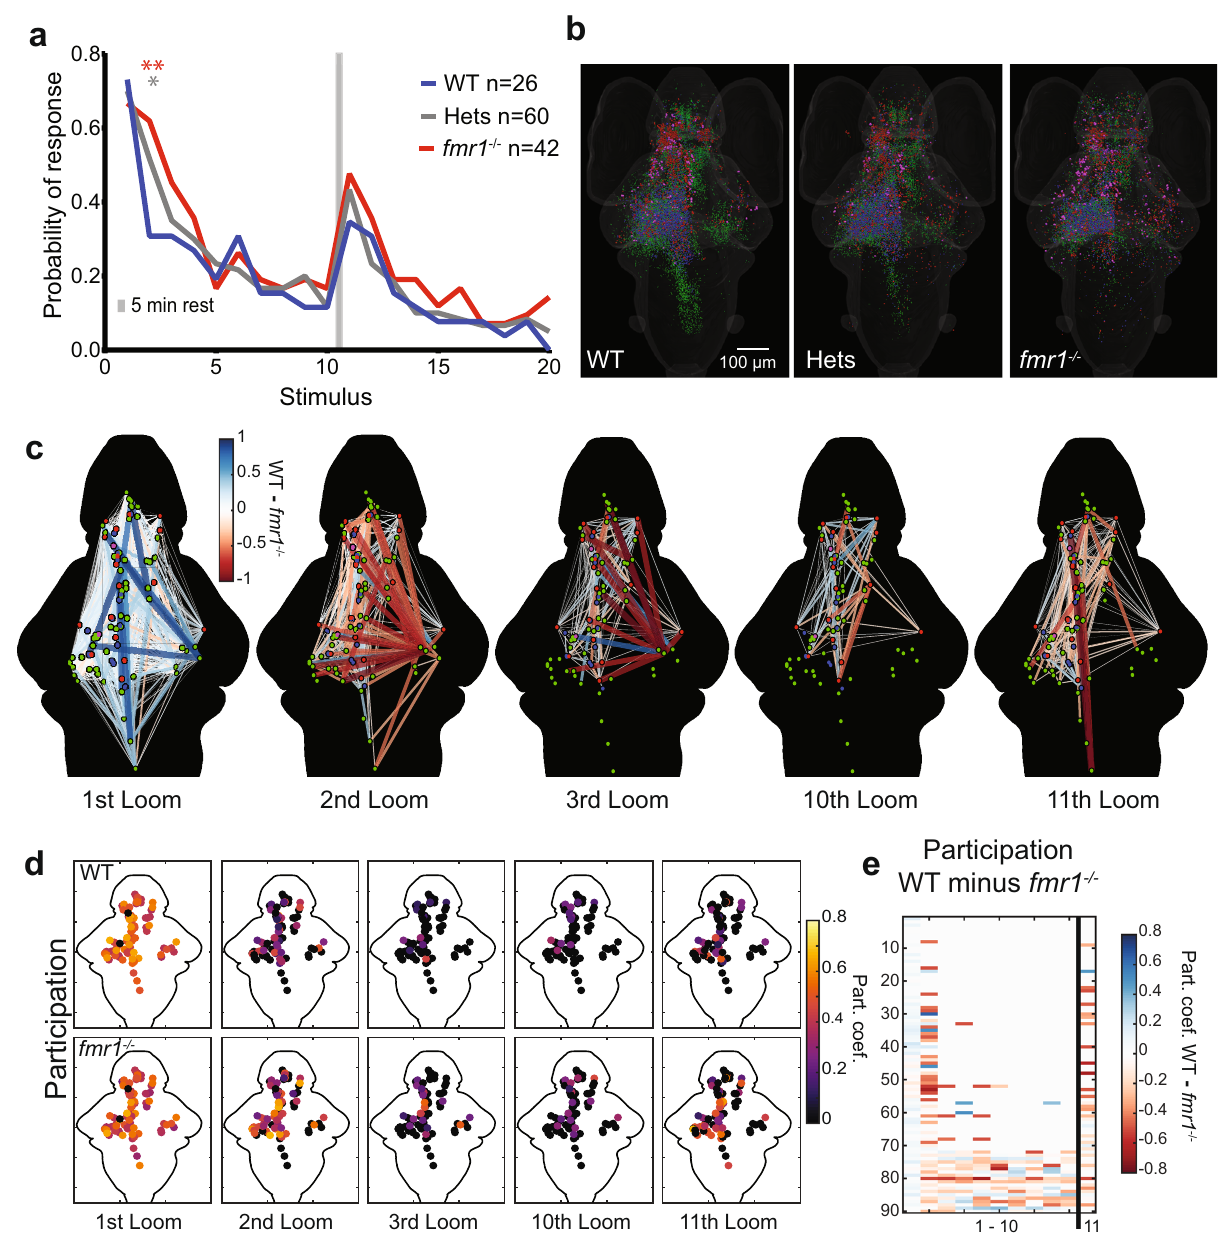
Fig. 5 Behavioral and network-wide changes in fmr1 − / − larvae. a Probability of response across the three groups to two blocks of ten looms. Over the course of two blocks of 10 stimuli, fmr1 − / − larvae show slower habituation and stronger recovery than WT siblings, and heterozygotes show an intermediate phenotype. One-sided binomial test: fmr1 − / − versus WT: 2nd Loom ( p = 3.056e − 5 ); 3rd Loom ( p = 0.034); 11th Loom ( p = 0.055); 16th Loom ( p = 0.039). Heterozygotes versus WT: 2nd Loom ( p = 0.001) and 9th Loom ( p = 0.039). All other comparisons ( p > 0.1). Signi fi cance cutoffs using a Bonferroni correction are * p < 0.00125 and ** p < 0.00025, equivalent to uncorrected p < 0.05 and 0.01, respectively. b Brain-wide distributions of ROIs for the three genotypes, color-coded for functional cluster as in Figs. 2 and 3a. A random sample ( n = 11) of Hets was selected to match WT ( n = 10) and fmr1 − / − ( n = 11). c Node-based graphs showing relative correlations (WT correlation minus fmr1 − / − correlation), where blue indicates correlations that are stronger in WT and red indicates correlations that are stronger in fmr1 − / − . Larvae imaged to generate the graphs for WT = 10 and fmr1 − / − = 11. d Heat maps of participation for all nodes across habituation and recovery. e A raster plot of relative participation (WT participation minus fmr1 − / − participation) for each node through the fi rst 11 and 3rd trials, as well as following recovery in the 11th trial re fl ecting recovery. In all regards, these effects resemble the (Fig. 6b, c). The distribution of the correlated edges is similar habituating graph dynamics shown for the f20 paradigm in Fig. 4, between the genotypes in the fi rst and 10th trials (Fig. 6b), where habituation tracks with a loss of communication between showing that the graphs are similar in the naive state and weakly habituating (red) nodes and strongly habituating (green) following habituation. Consistent with the analyses in Figs. 5c nodes, connected through moderately habituating (blue) nodes. and 6a, this fi nding suggests that uncoupling across functional By comparison, fmr1 − / − animals show more strong correlations, and therefore more edges, between numerous nodes in the 2nd clusters occurs more slowly and recovers more completely in